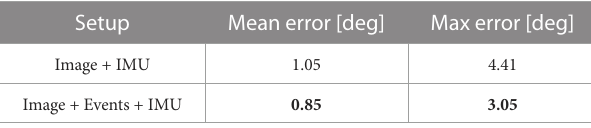
TABLE1 Resultsforconventionalvs.event-based(openloop)approaches, whenperformingarotationonthe z -axis.